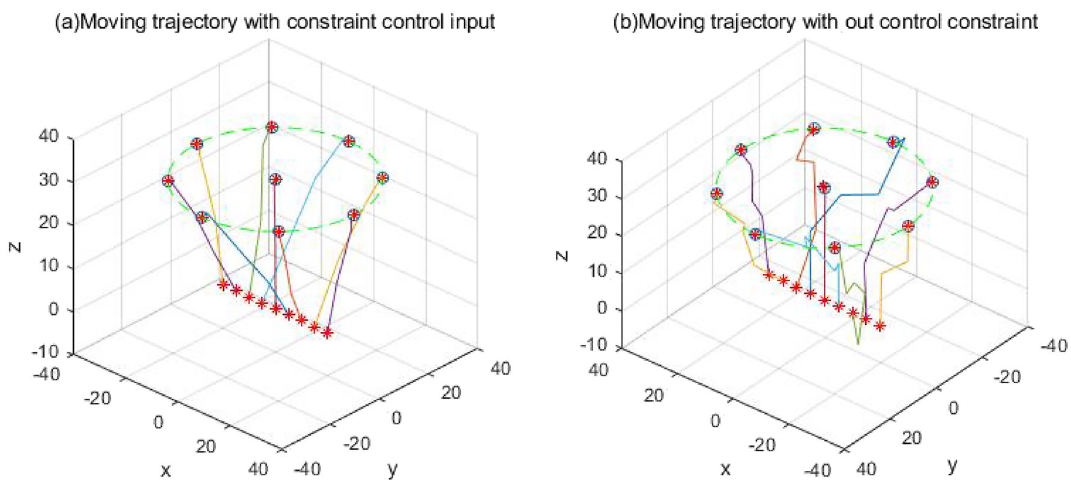
Fig. 13 Effect of constraints on generated trajectory